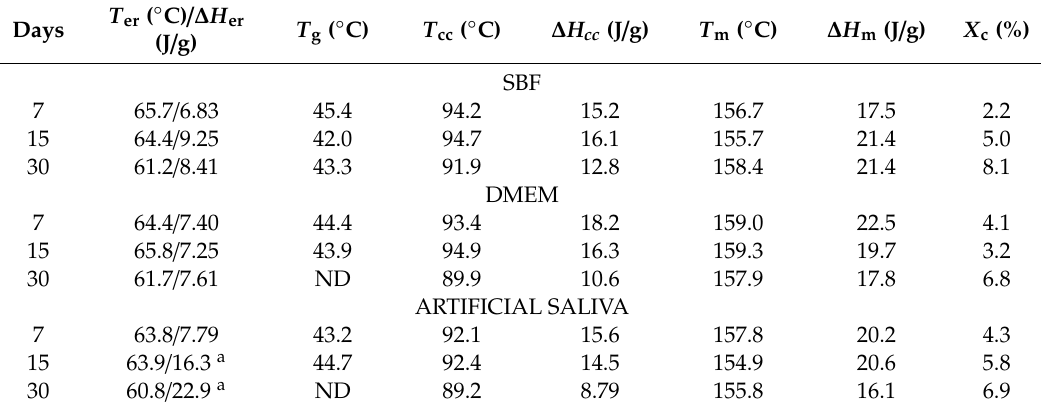
Table 4. Transition temperatures and enthalpies for irradiated PLGA nonwovens obtained in di ff erent in vitro degradation